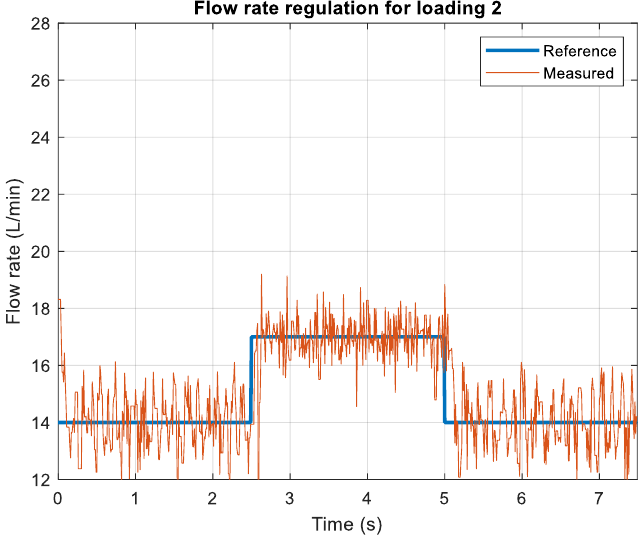
Figure 15. Experimental results for loading condition 2.